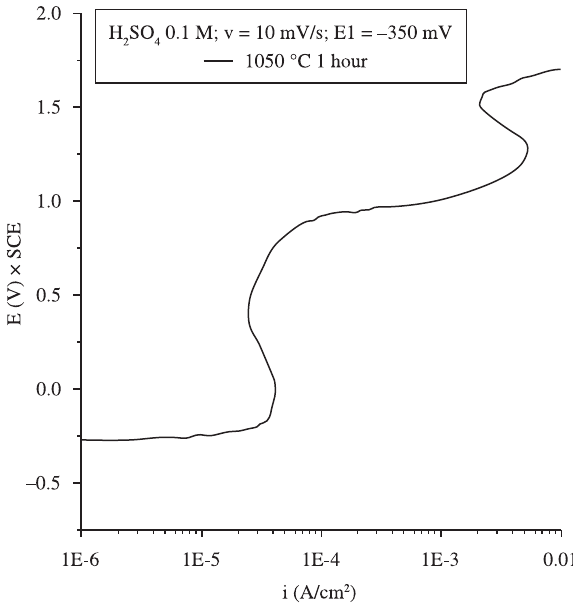
Figure 3. Typical anodic potentiodynamic polarization curve of the duplex stainless steel solubilized at 1050 ° C for 1 hour. Solution: H v = 10 mV/s.